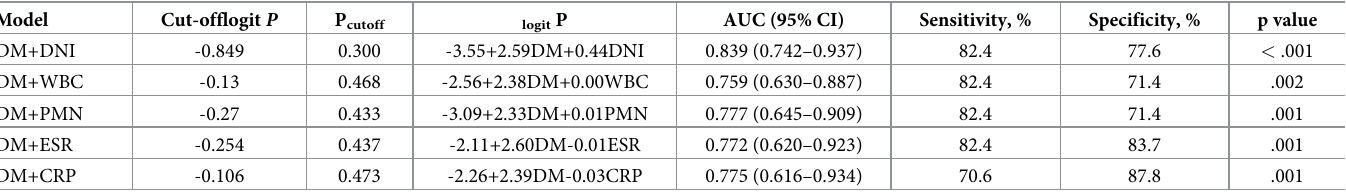
Table 4. Combined DM modalities of the inflammatory markers.